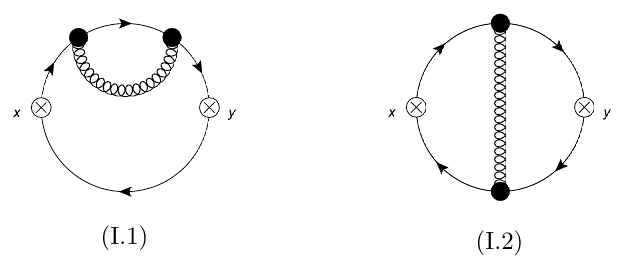
Figure 4. Type I diagrams for the evolved 2-point vector correlator at O ( g 2